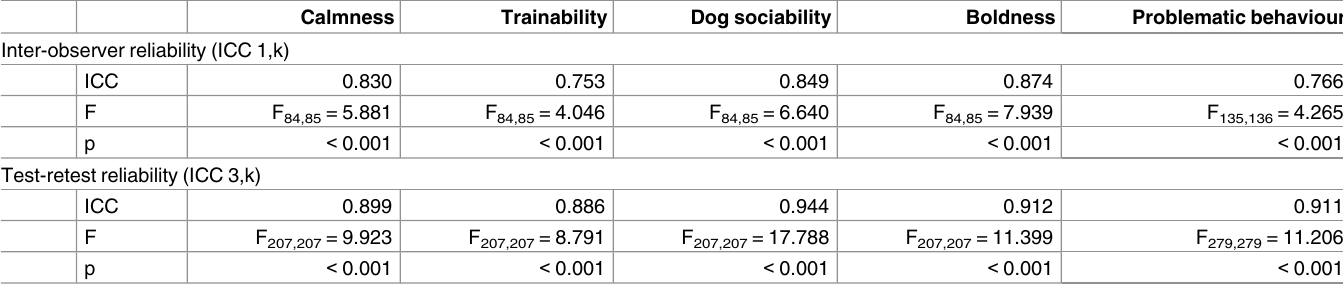
Table 1. Reliability measuresof the five behaviour